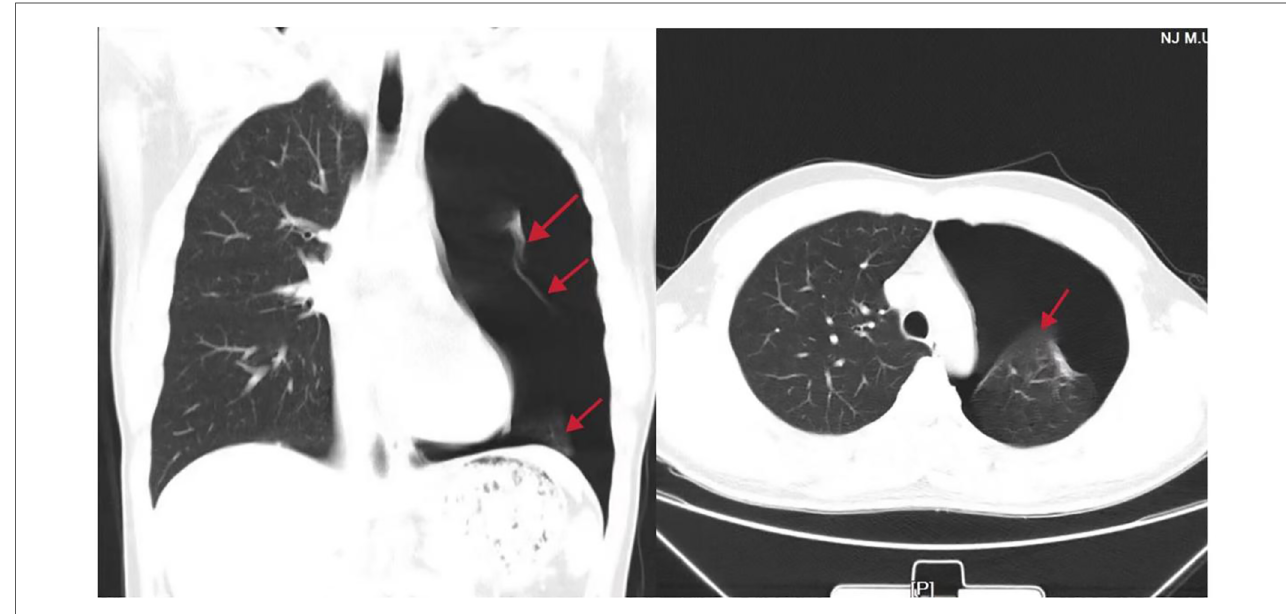
FIGURE 1 Preoperative chest radiograph and computed tomography scan showing an 80% – 90% left-sided pneumothorax (red